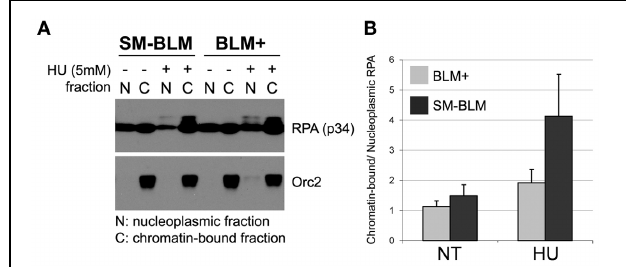
FIGURE 3 | Increased levels of RPA accumulate on chromatin in HU-treated SM-BLM cells. BLM + and SM-BLM cells were untreated or treated with 5mM for 6h. (A) Chromatin and nucleoplasmic fractions were isolated from cells and solubilized RPA was analyzed by immunoblot using antibodies to the p34 subunit. Orc2 was used for quality control of the preparation of the chromatin-bound fraction. (B) Graph depicting the ratio of chromatin-bound RPA to nucleoplasmic RPA. A minimum of two independent experiments were carried out on each of two BLM + and two SM-BLM clones. Error bars represent the standard deviations of the combined